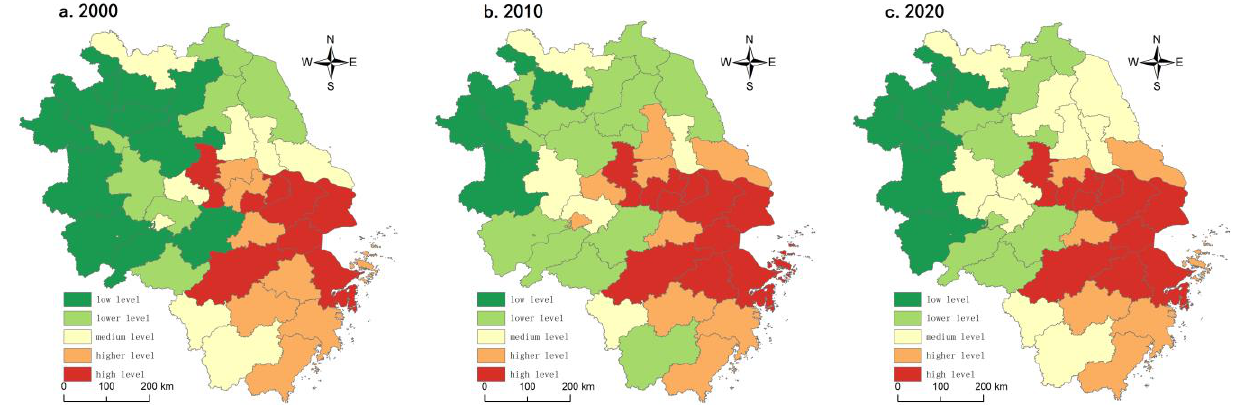
Figure 8. Economic development level of the Yangtze River Delta region, 2000–2020.